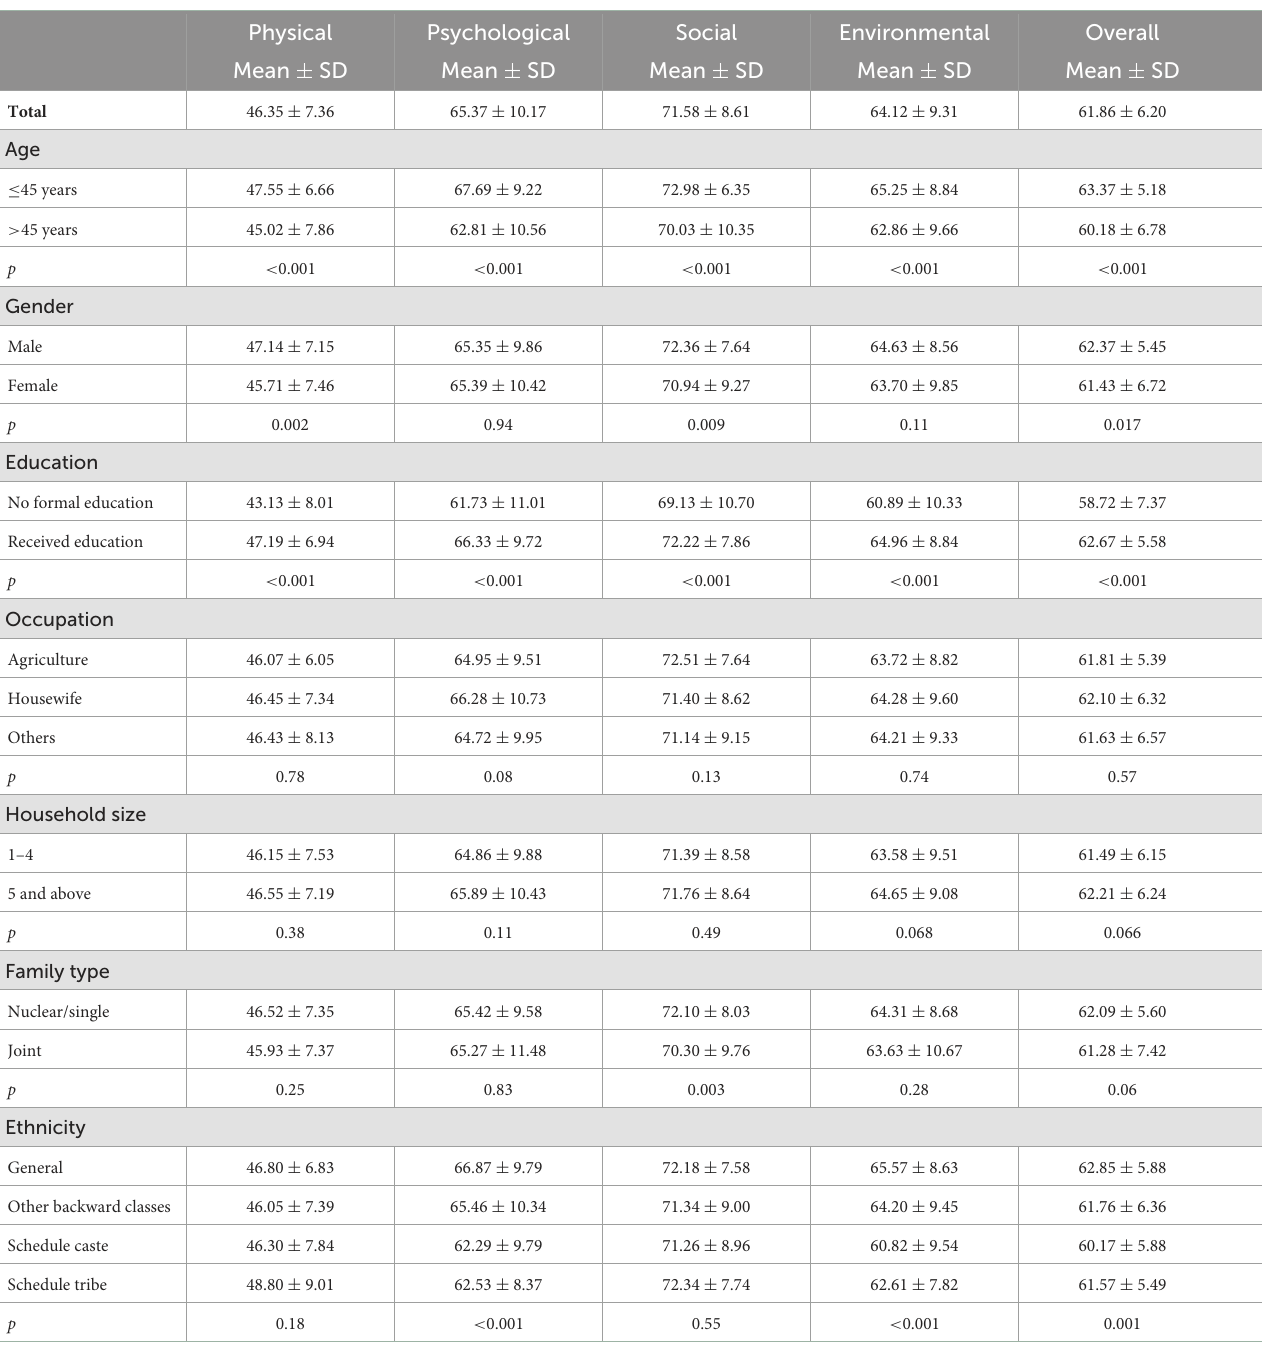
TABLE 4 WHO-QOL BREF scores based on socio-demographic variables. Physical Psychological Social